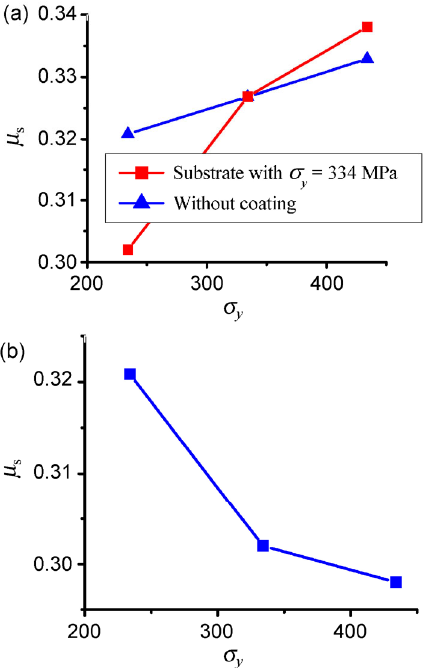
Fig. 5 (a) Variation of the SFC with respect to an increase of the yield strength in the coating with the substrate ( 334 MPa)   y as the red curve, and the substrate with the same yield strength of coating (i.e., “without coating”) as the blue curve. (b) Variation of the SFC with a rising yield strength in the substrate for the coating with a constant yield strength 234 MPa   y